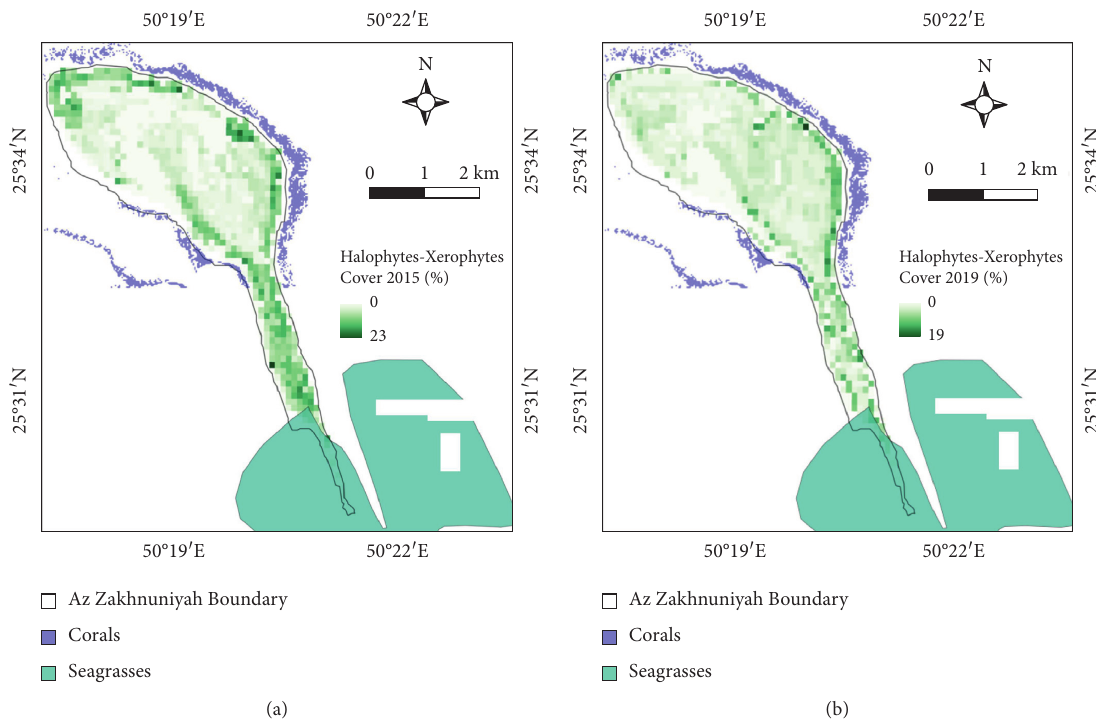
Figure 11: Plant communities map including corals, seagrasses, and halophytic/xerophytic plants. Halophytic/xerophytic plants cover fraction for years (a) 2015 and (b) 2019. Table 7: Statistics comparison fractional cover (%) of halophytic/xerophytic plants between 2015 and 2019. Fractional cover